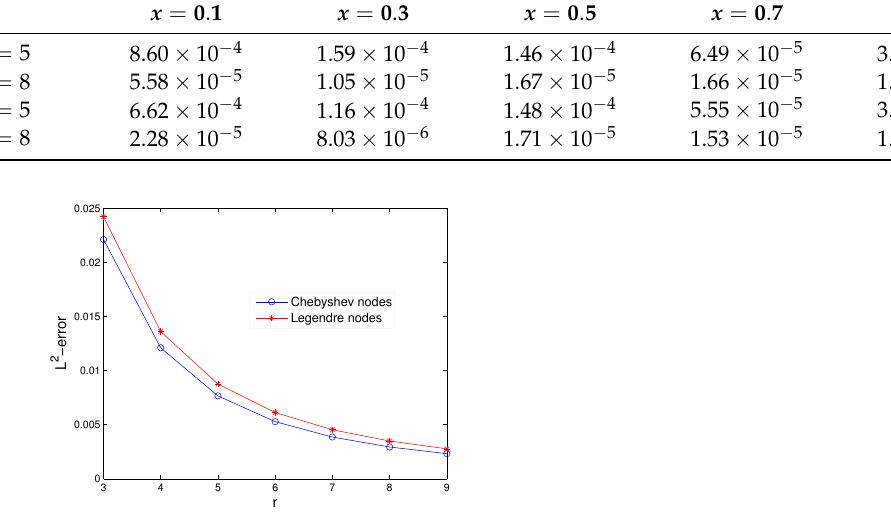
Figure 4. The L 2 –errors for β = 1/2 and µ = 1 at the Chebyshev and Legendre nodes for Example 3.